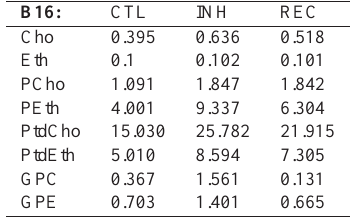
Table 3: Average concentrations of B16 melanoma tumor model metabolites B16: CTL INH